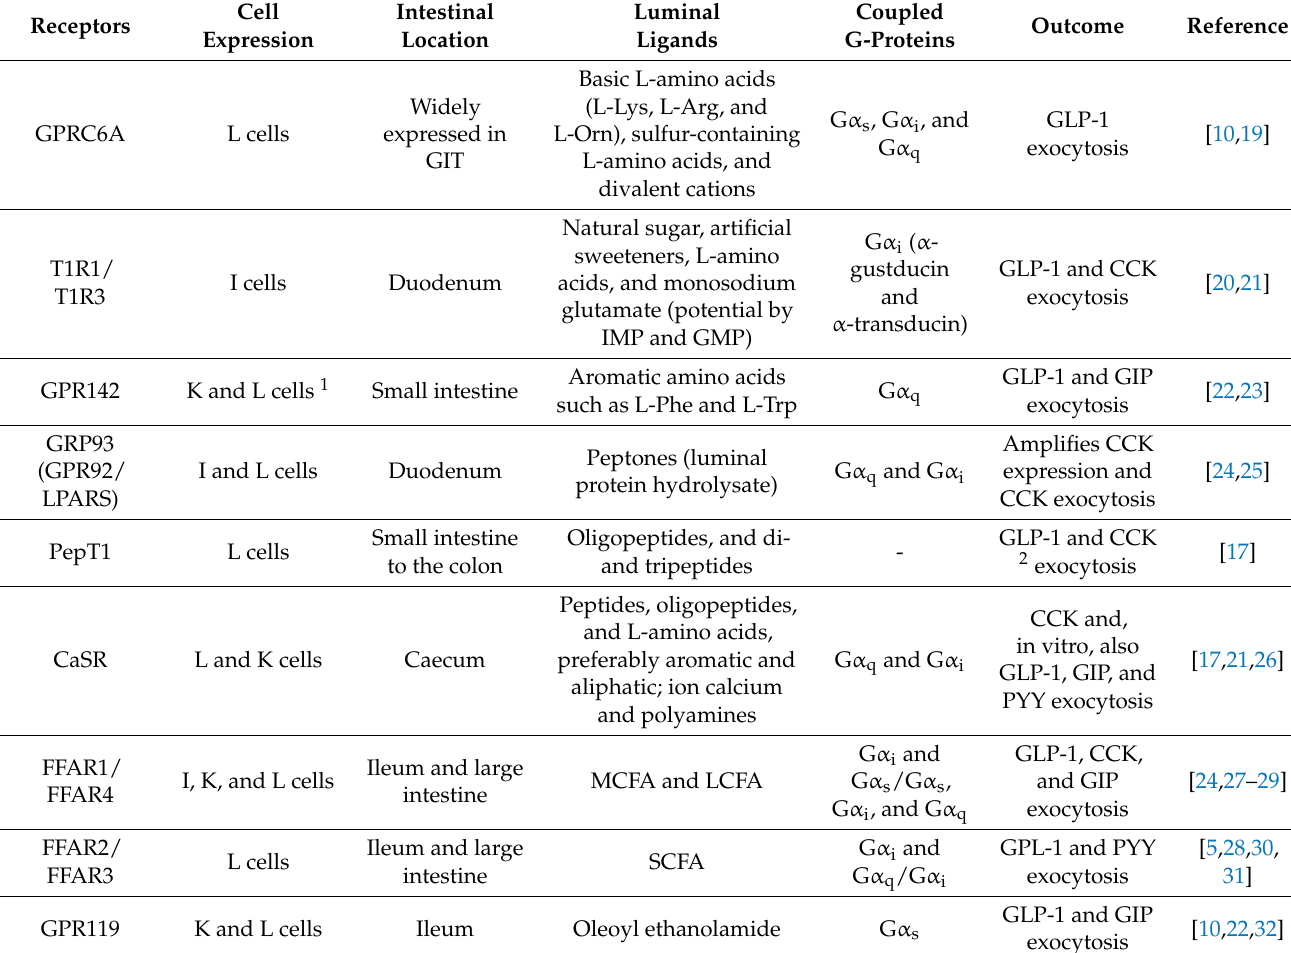
Table 1. Summary of the main G-protein-coupled receptors